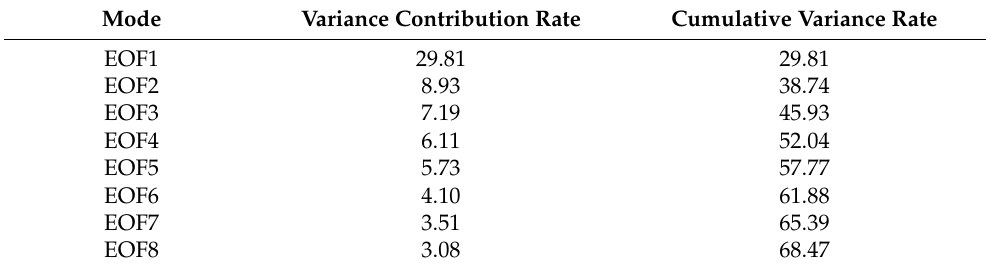
Table 1. The variance contribution rate and cumulative variance rate (unit: %) of the first eight modes.